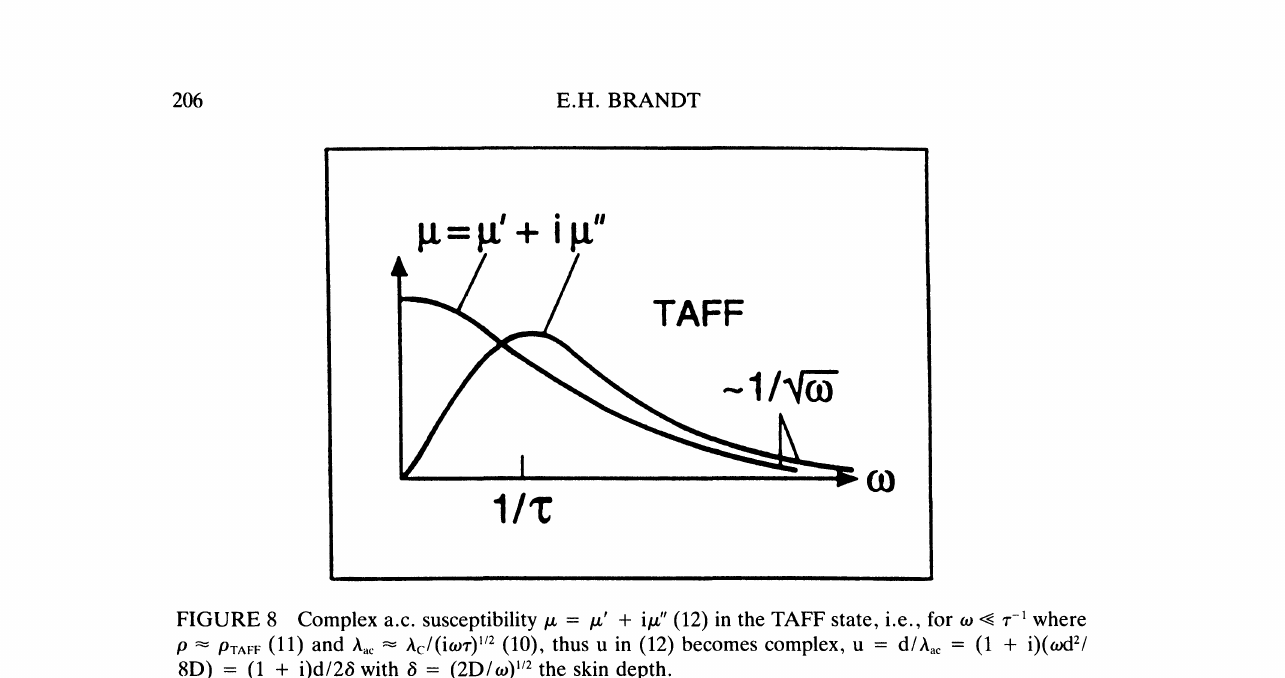
FIGURE 8 Complex a.c. susceptibility/z /z’ + i/z" (12) in the TAFF state, i.e., for o P PTAF" (11) and h,c hc/(io’) /2 (10), thus u in (12) becomes complex, u d/Aac (1 8D) (1 + i)d/2 with 15 (2D/o) ’ the skin